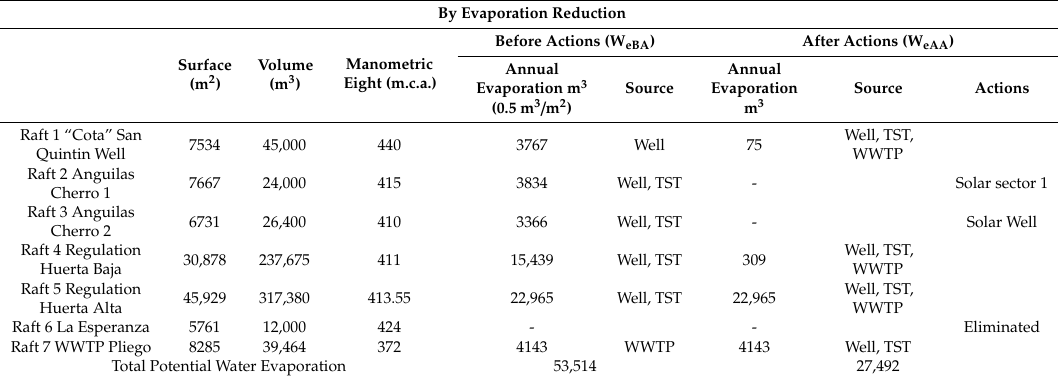
Table 4. Summary of potential water evaporation. Source: Own